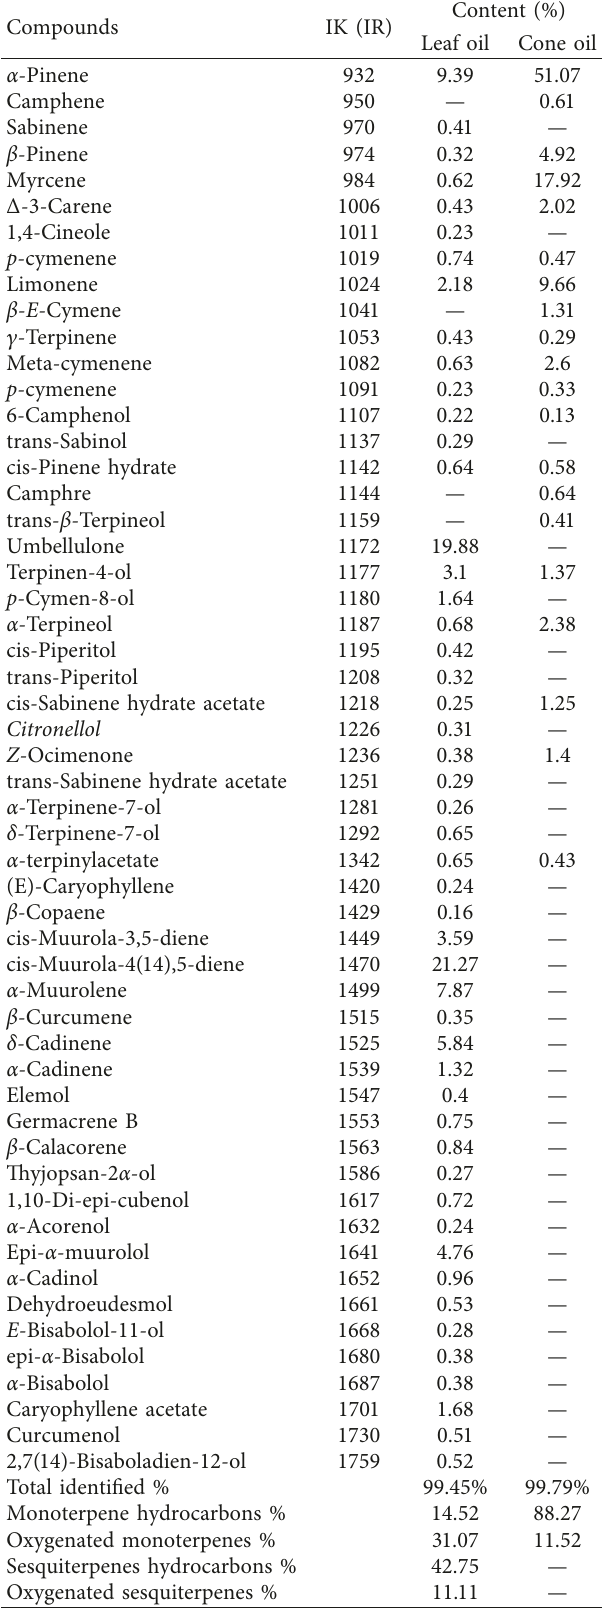
Table 1: Chemical composition of